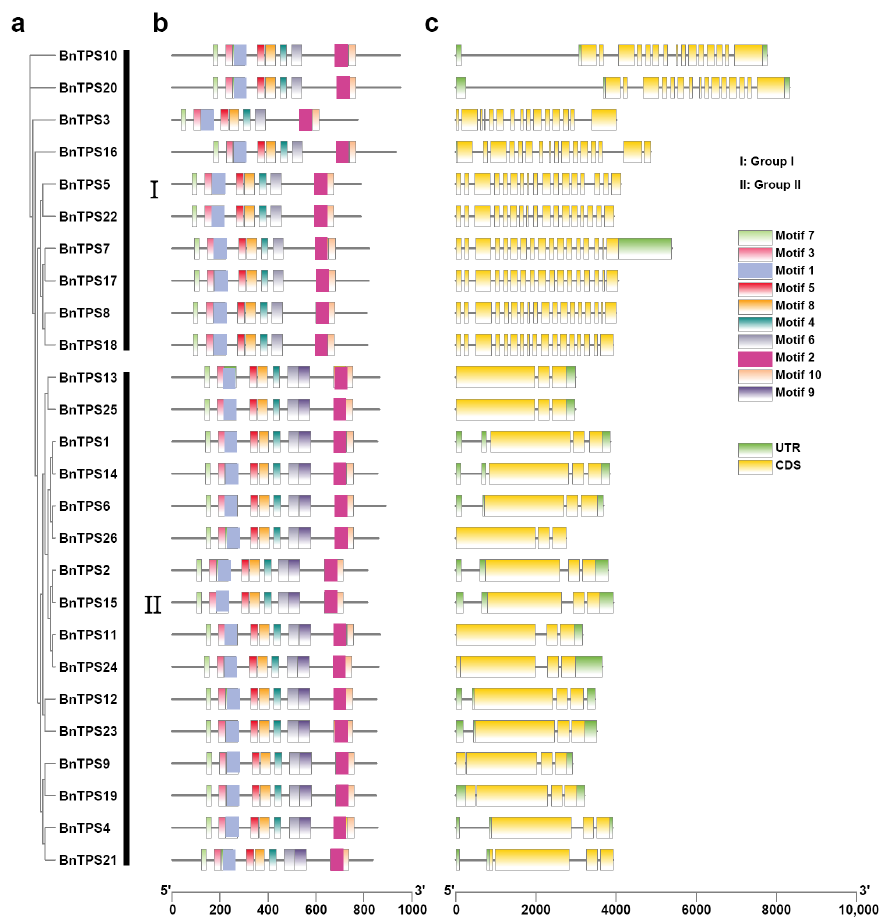
Figure 3. The phylogenetic tree, gene structure, and conserved motifs of 26 BnTPS genes. ( a ) The phylogenetic tree of 26 BnTPS genes. ( b ) The conversed motif composition of BnTPS genes. Different colors represented different motifs. ( c ) Gene structures of the BnTPS genes. Yellow boxes, green boxes, and grey lines represent UTR, CDS, and introns, respectively.